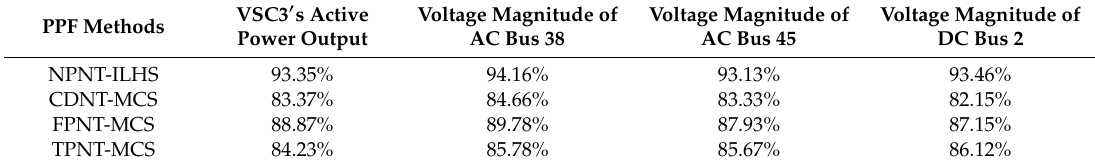
Figure 11. Frequency histograms of PPF results: ( a ) the frequency histograms of the VSC3 ′ s active power output; ( b ) the frequency histograms of voltage magnitude of AC bus 38. Table 5. FHSIs obtained by using NPNT-ILHS, CDNT-MCS, FPNT-MCS, and